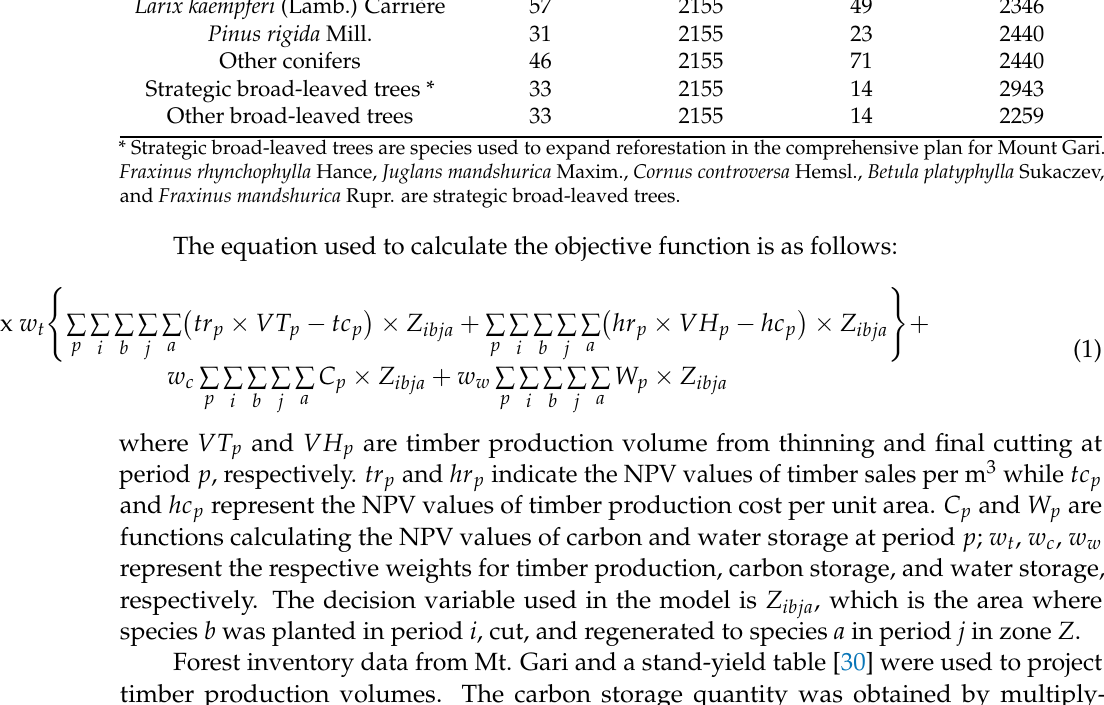
Table 2. Unit profit and cost of timber harvest by tree species [22]. Thinning Final Cutting Species Profit Cost Profit Cost ($ per m 3 ) ($ per ha) ($ per m 3 ) ($ per ha) Pinus koraiensis Siebold & Zucc. 48 2155 38 2183 Larix kaempferi (Lamb.) Carri è re 57 2155 49 2346 Pinus rigida Mill. 31 2155 23 2440 Other conifers 46 2155 71 2440 Strategic broad-leaved trees * 33 2155 14 2943 Other broad-leaved trees 33 2155 14